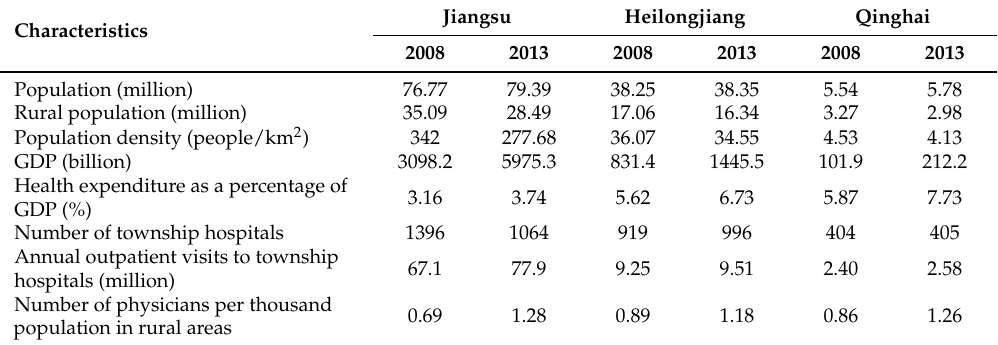
Table 1. Populations, health spending and health workforce in Jiangsu, Heilongjiang and